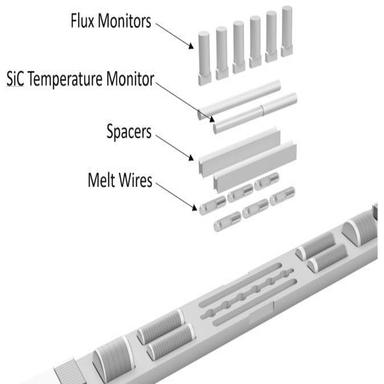
Schematic of the standard capsule fixture with instrumentation. Flux monitors, melt wires, and temperature monitors are included in the standard capsule design.